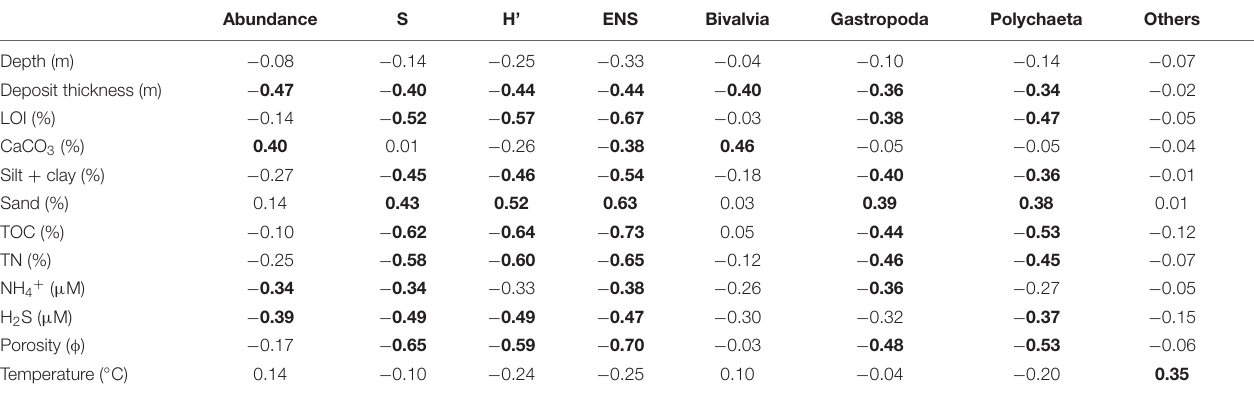
TABLE 5 | Pearson correlation coefficients ( r ) for significance between biotic and sediment factors for core/grab data from 34 samples collected at 17 locations in the Indian River Lagoon; abundances of organism groups, richness (S), Shannon-Wiener diversity index (H (cid:48) ), and effective number of species (ENS). Abundance S H’ ENS Bivalvia Gastropoda Polychaeta